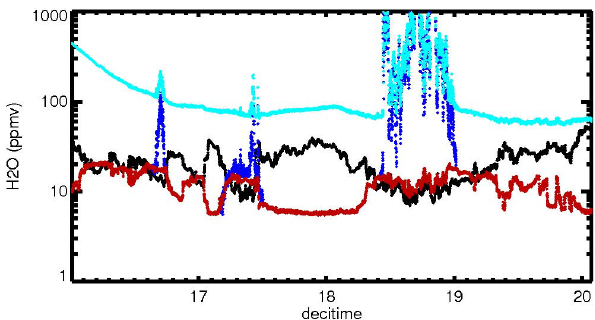
Fig. 1. This figure illustrates the H 2 O data quality check using data obtained by the CLH during the CRYSTAL-FACE campaign on 9 July 2002. The black line is H 2 Osat, the red line is H 2 O gas , the turquoise line is H 2 O enh , and the dark blue line is H 2 O enh , adj .